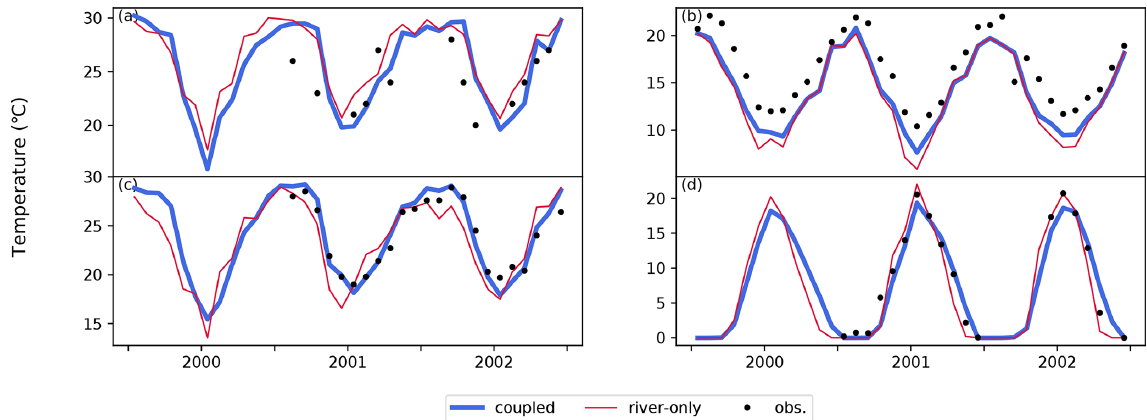
Figure 7. Time series of monthly mean values of river temperature ( ◦ C). Black dots show the observed values, and blue (red) lines show values calculated by the coupled (river-only) simulation for (a) 00MS13SM2000 station on the Rio Santa Maria, (b) Hamilton traffic bridge station on the Waikato River, (c) Puerto Libertad station on the Paraná River, and (d) Neva River station on the Neva River. The GEMS station codes for these stations are BRA01900, NZL00013, ARG00001, and RUS00014,